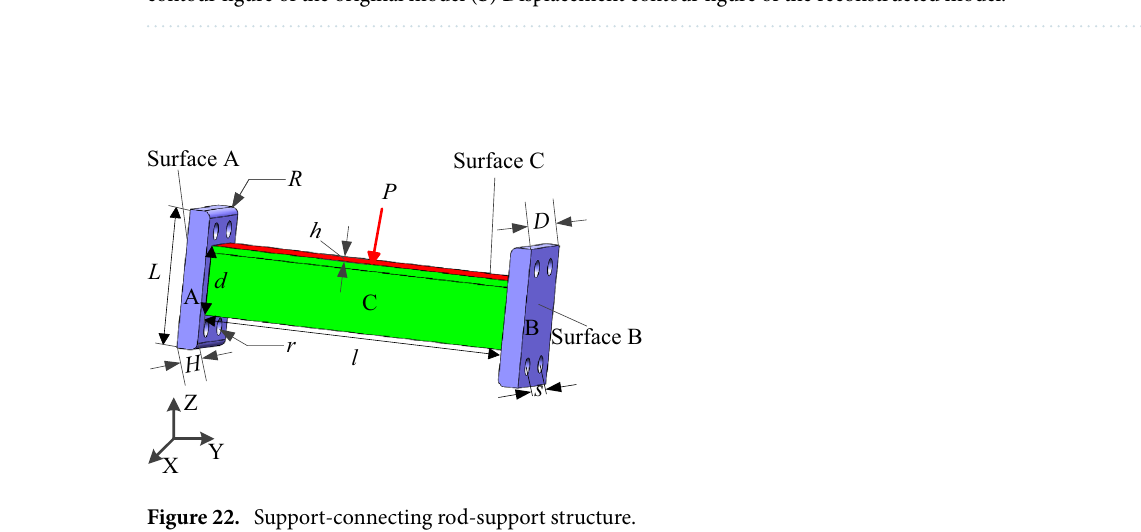
Figure 21. Comparison of displacement contour figures before and after optimization. ( a ) Displacement contour figure of the original model ( b ) Displacement contour figure of the reconstructed model.